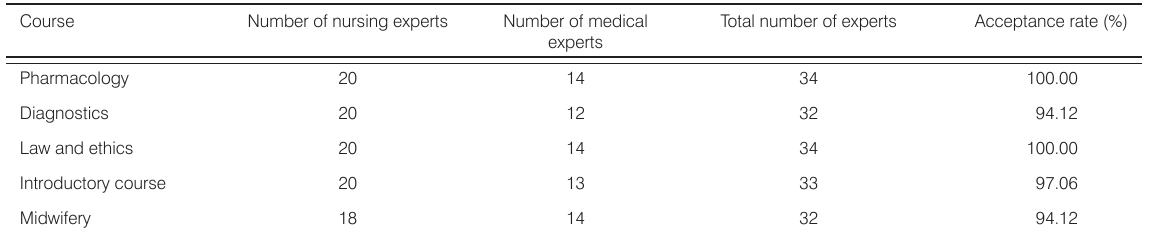
Table 8. The consensus on the training courses for prescriptive authority for midwives ( n =